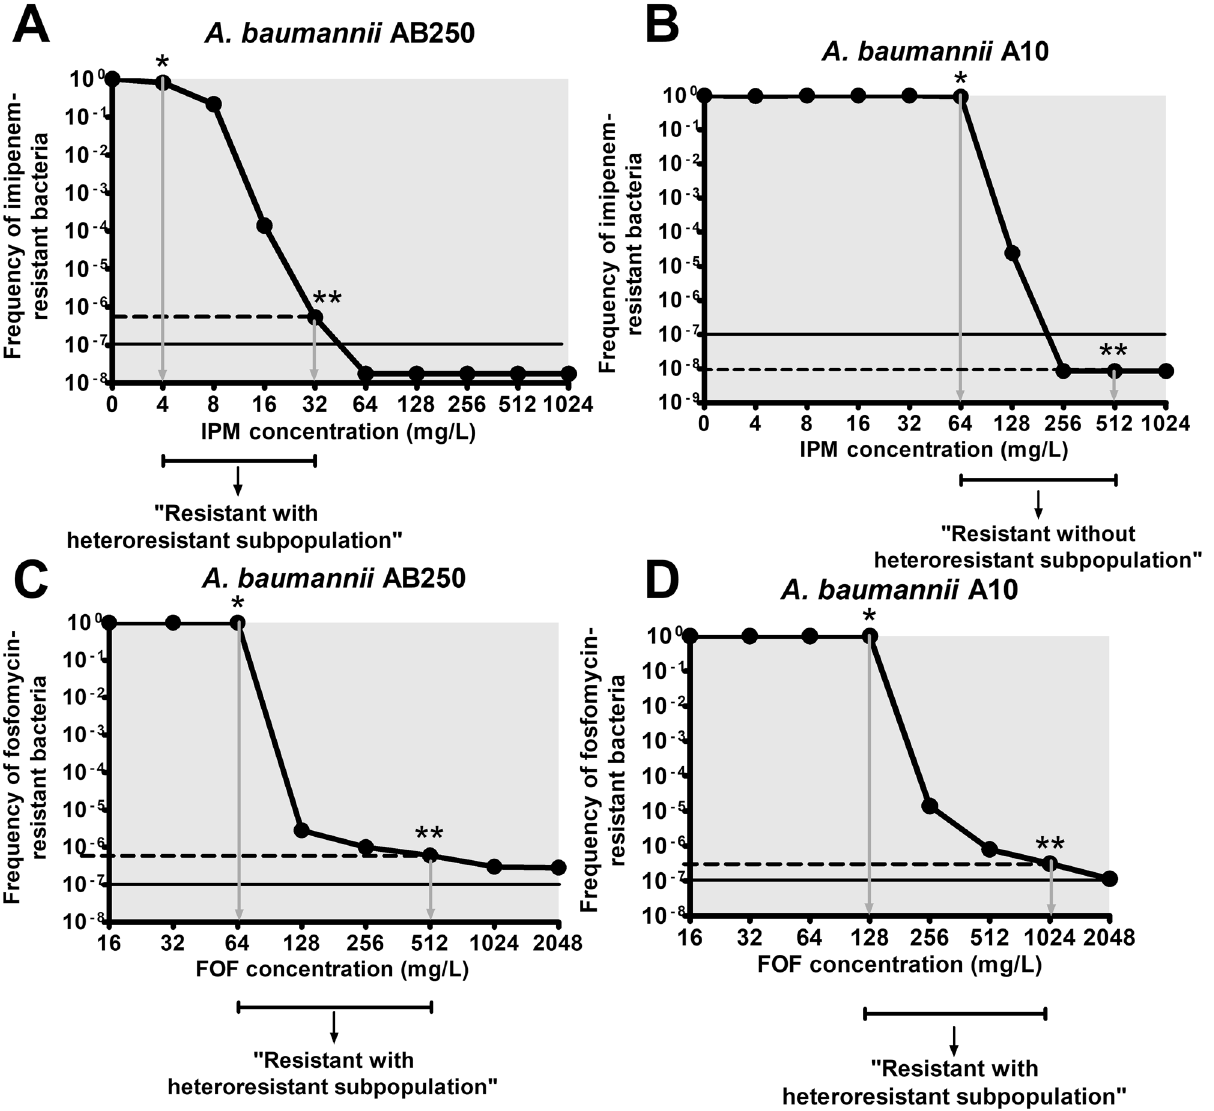
Figure 8. PAP of imipenem and fosfomycin in A. baumannii AB250 ( A , C ) and A10 ( B , D ). The frequency of antibiotic-resistant bacteria was the relative of viable cells at each antibiotic concentration normalized to those at the absence of antibiotic. All experiments were performed in triplicate. Mean values of the frequency of antibiotic-resistant bacteria were plotted with error bars representing the standard error of the mean (n = 3). The “resistant with heteroresistant subpopulation” was defined as that the frequency of antibiotic-resistant bacteria at eightfold above the resistance level of the main population (dash lines) was higher than 10 –7 . *: antibiotic concentration (the resistance level) of the main population, **: eightfold above antibiotic concentration (the resistance level) of the main caused by the excess of cell wall materials. It is the limitation of our study that the bacterial metabolites were not determined. In combination of 0.5× fosfomycin with 1× imipenem that did not affect bacterial growth (Fig. 2A–F), imi- penem showed a tiny role on the recycling expression in non-synergistic strain, indicating an inert response of AB250. In contrast, the significant downregulation of the recycling was observed in synergistic strain, suggesting enhance effect of imipenem in perturbation of the recycling of A10. Therefore, imipenem may be synergistic with fosfomycin at least in part downregulation of the cell wall recycling. The targets of imipenem are PBPs, not the cell wall recycling, thus imipenem indirectly plays a role on the recycling. The cell wall synthesis is composed of the precursor production (the de novo or recycling bypath) and peptidoglycan crosslinking (by the PBPs). Both processes are inevitably related and sophisticated. Many studies are supporting the hypothesis that imipenem not only inhibits PBPs, but also interrupts other cellular metabolisms 44,45 . For instance, mecillinam, whose targets are PBPs, simultaneously blocks the PBPs and enhances a cycle of cell wall synthesis and turnover via the Rod system, resulting in depleting PG precursor pools in E. coli . Similar to a report in A. baumannii 46 , imipenem affects not only PBP2 and PBP1a, but also perturbs the Rod